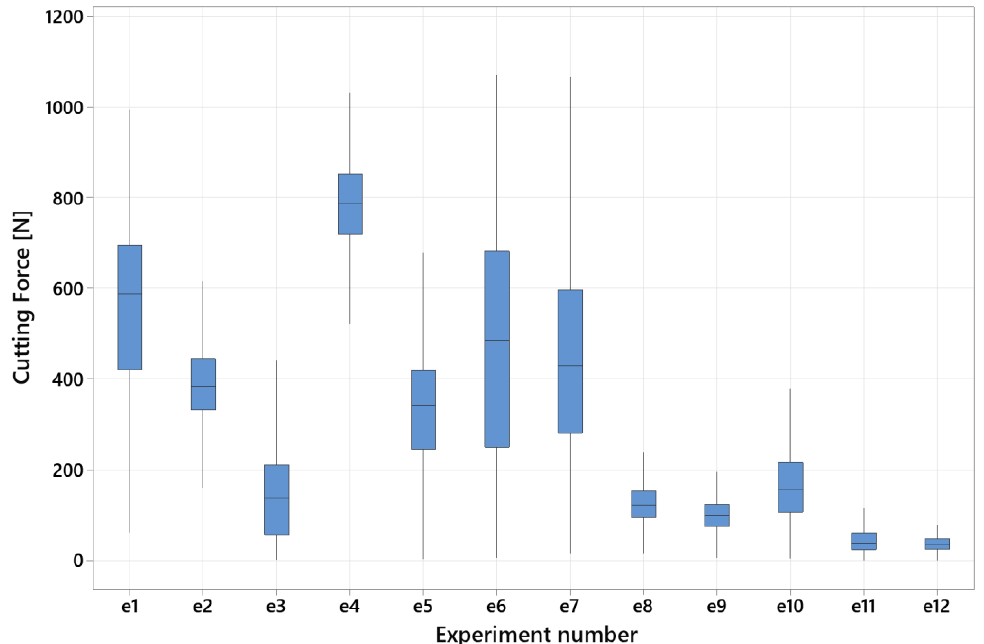
Figure 6. Total cutting force in individual experiments.